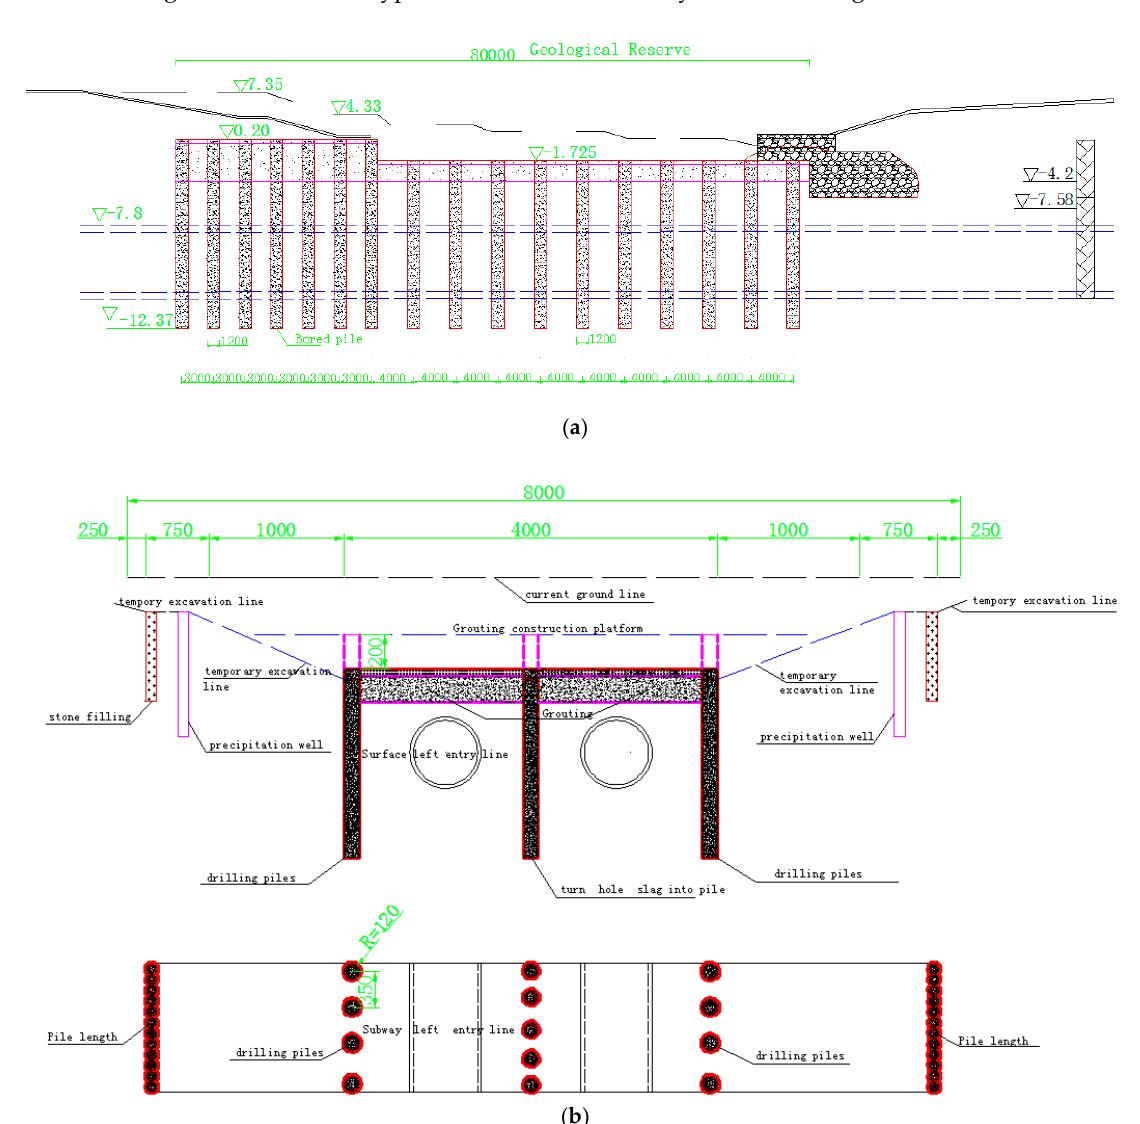
Figure 3. Typical cross-section form. ( a ) Longitudinal section of the subway vertical cross-section protection scheme; ( b ) Cross-section of the subway intersecting the fork section excavation area protection.